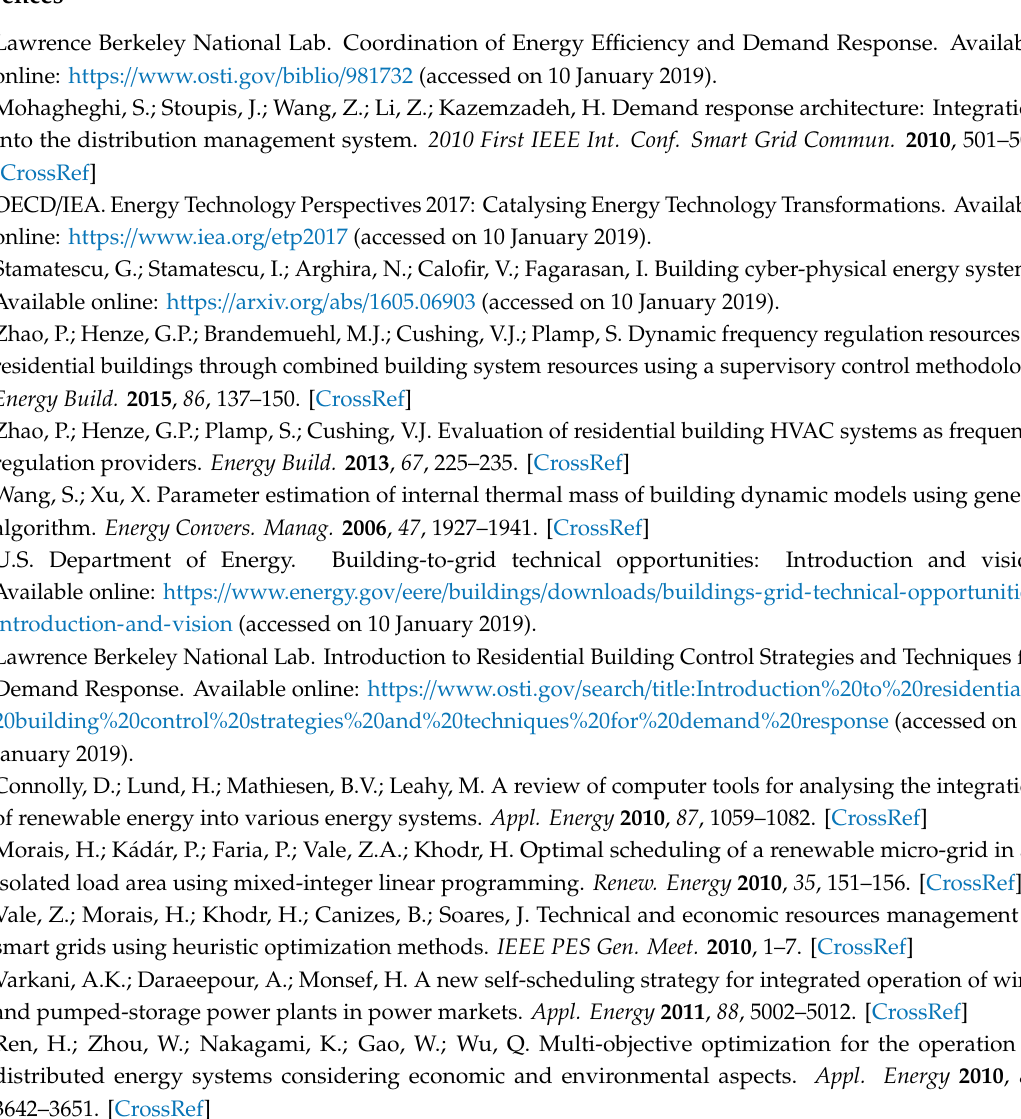
Figure A3. ESS minute operation example of 14:00–15:00, 14 August 2017.